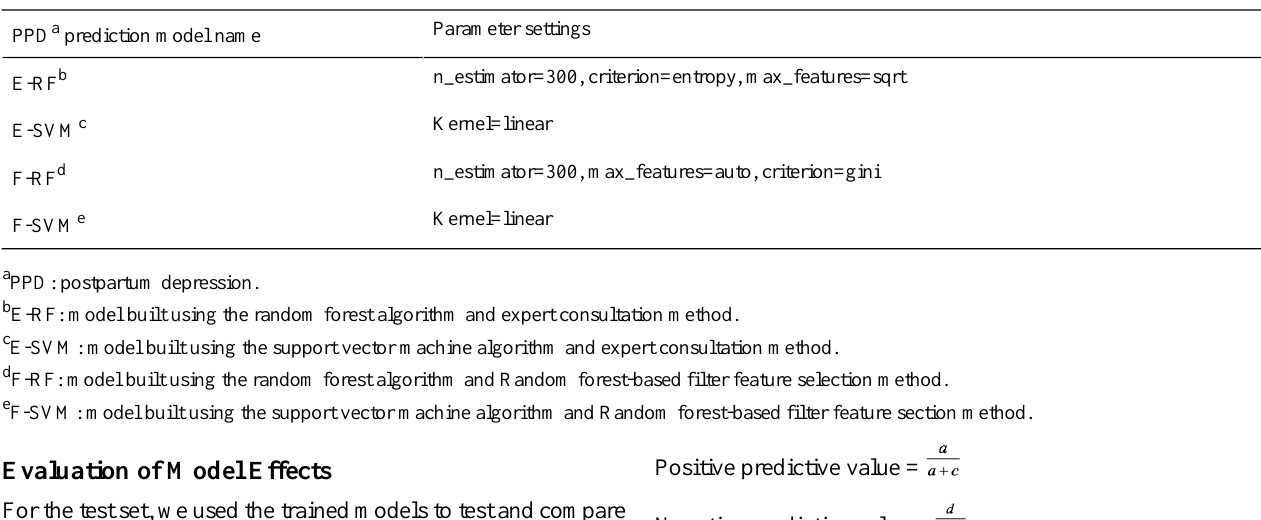
Table 2. Optimal parameters for each model.